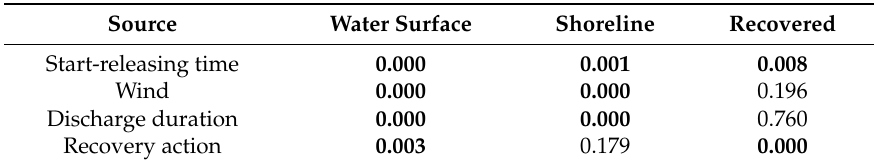
Table 3. The p -values for the influence of studied factors on oil mass balances. Significant influence ( p -value < 0.05) is shown in